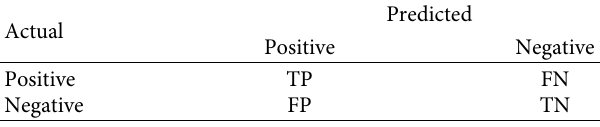
Table 3: Confusion matrix.